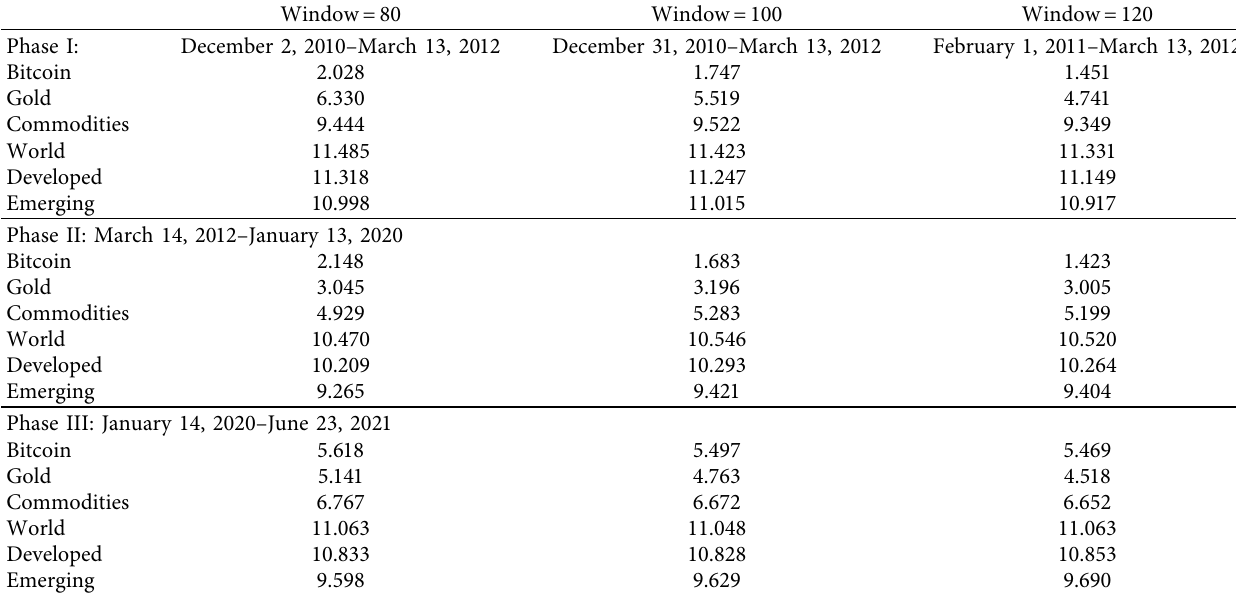
Table 4: Dynamic from spillover with different rolling windows.